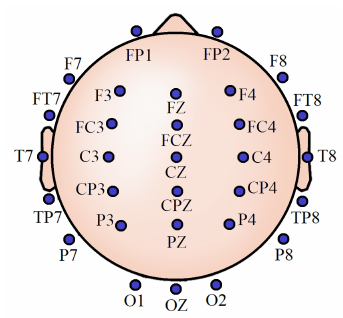
Figure 1. Thirty-channel electroencephalogram (EEG) scalp